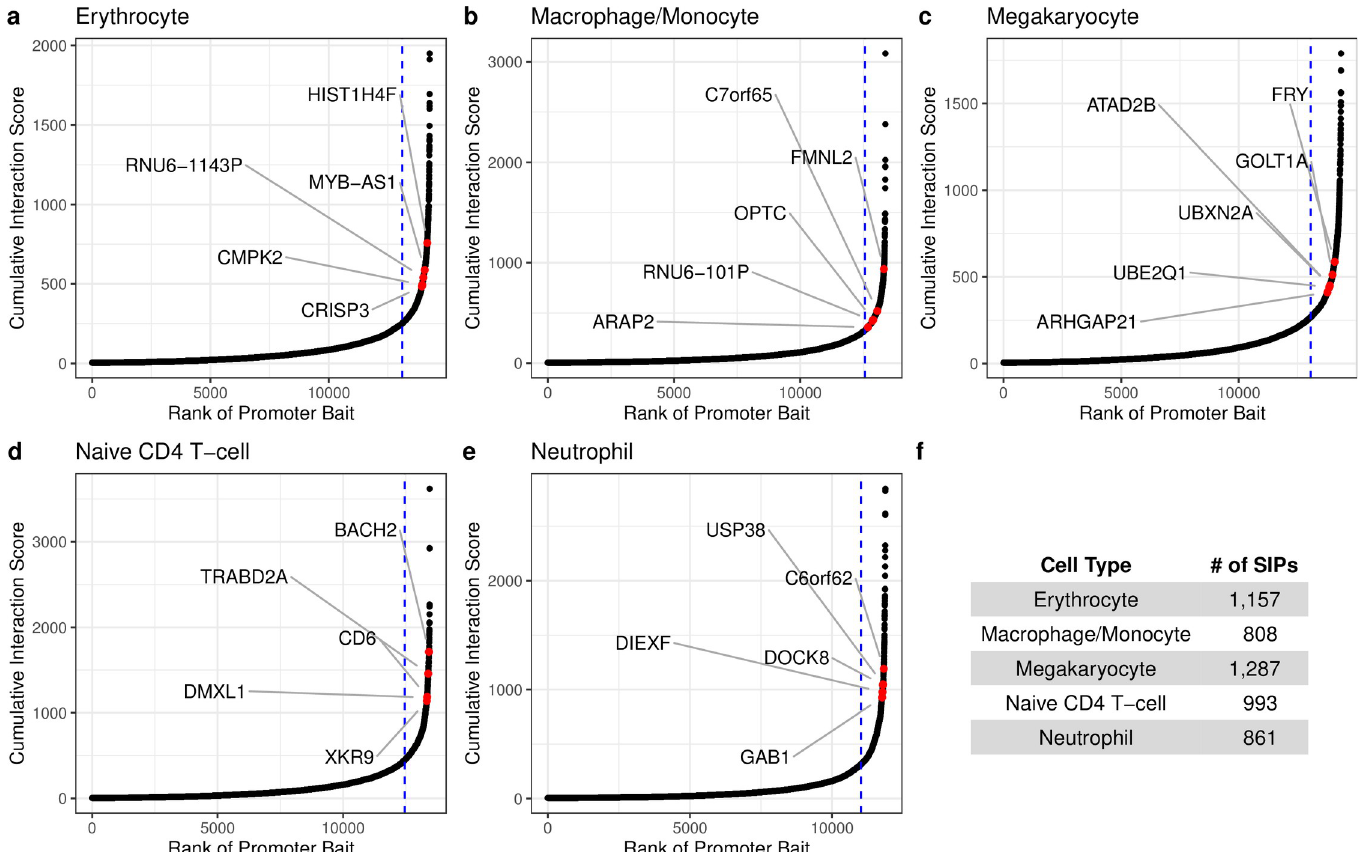
Fig 1. There are few super-interactive promoters (SIPs) in the chromatin interactome. (A)-(E) Hockey plots for each cell type show the ranked cumulative interaction scores for pcHi-C promoter-containing anchor bins (baits). Promoters to the right of the blue vertical line are classified as super interactive promoters (SIPs), as they exhibit unusually high levels of chromatin interactivity. Red dots highlight the highest ranked cell type-specific SIP genes 1 with a PIR overlapping a relevant GWAS identified SNP. ( F ) Total number of SIPs annotated per cell type. 1 The megakaryocyte genes ATAD2B and UBXN2A correspond to the same SIP bait.